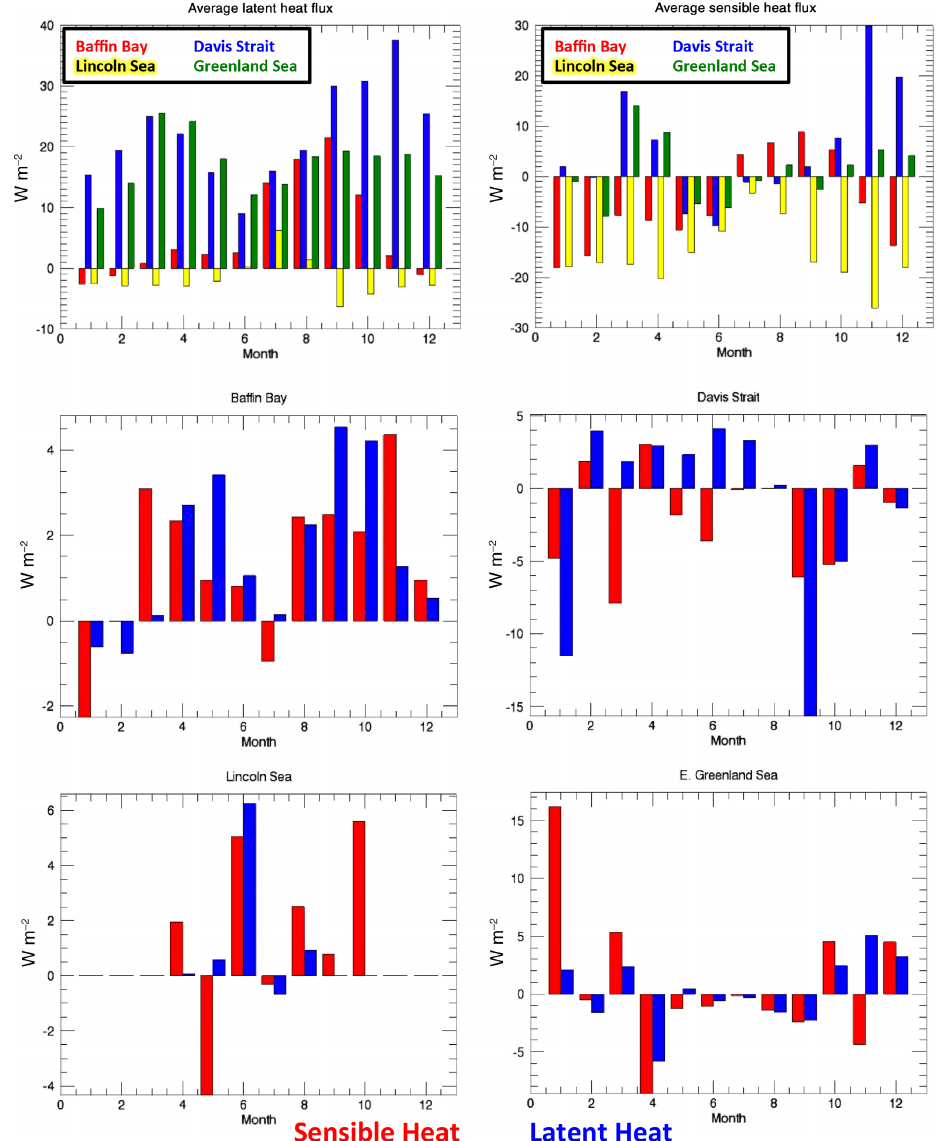
Figure 7. Top row graphs show the 2002 to 2015 average latent and sensible heat fluxes for each ocean region (denoted by color). The sign convention is such that positive fluxes are directed from the ocean to the atmosphere. Bottom two row graphs show the early minus late melt onset years for each region of the positive (into the atmosphere) sensible (red) and latent (blue) heat